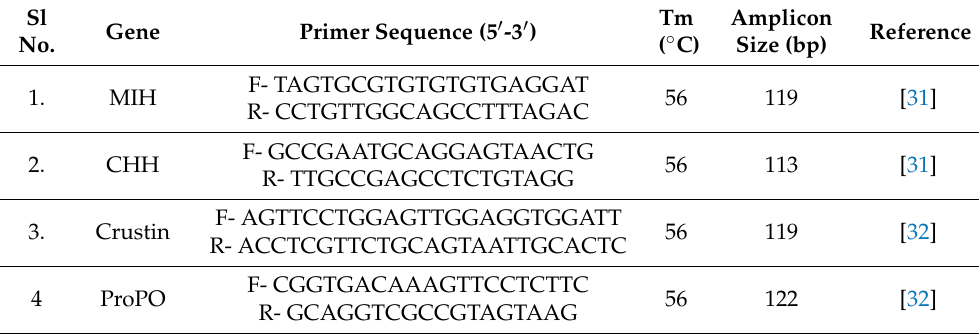
Table 1. Primer details of three genes used for absolute quantitative real-time PCR analysis.